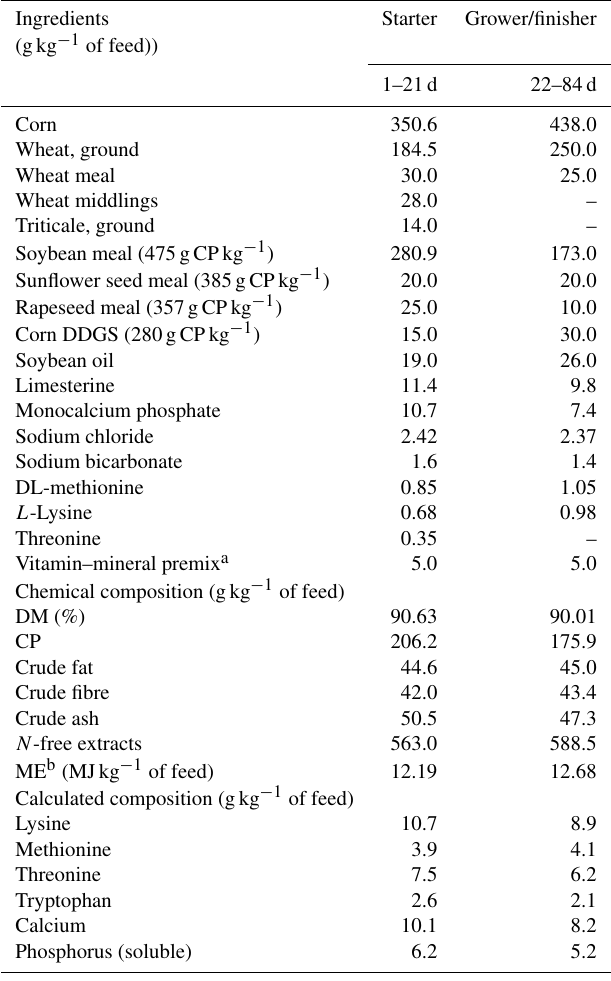
Table 1. Ingredients and chemical composition of the diets for